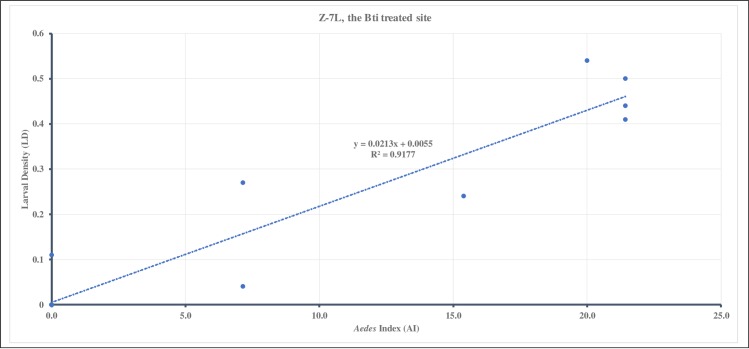
For 2015, the regression relationship between larval density (LD) and Aedes index (AI) during the 23 weeks of entomological surveillance conducted in Z-7L, the Bti treated site.There was a strong positive correlation (R2 = 0.92) between LD and AI.